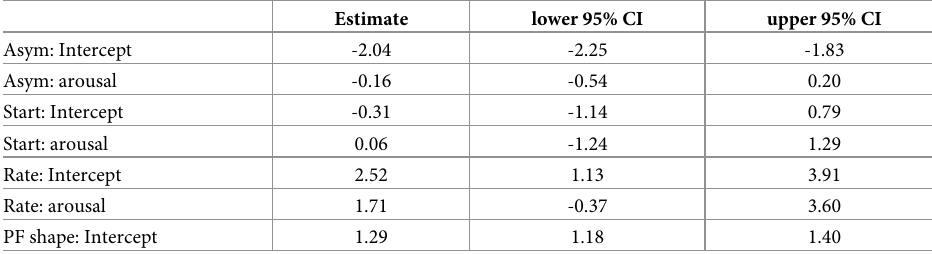
Table 5. Coefficient and CI from model testing arousal-manipulation effects in children. Estimate lower 95%